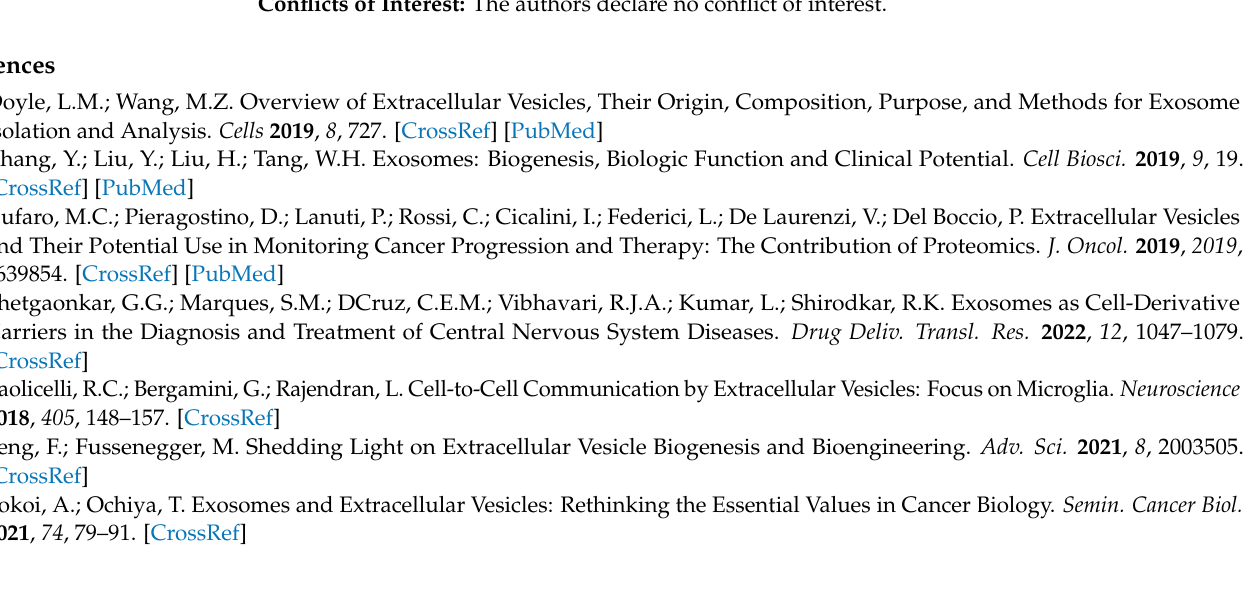
Table S1: List of